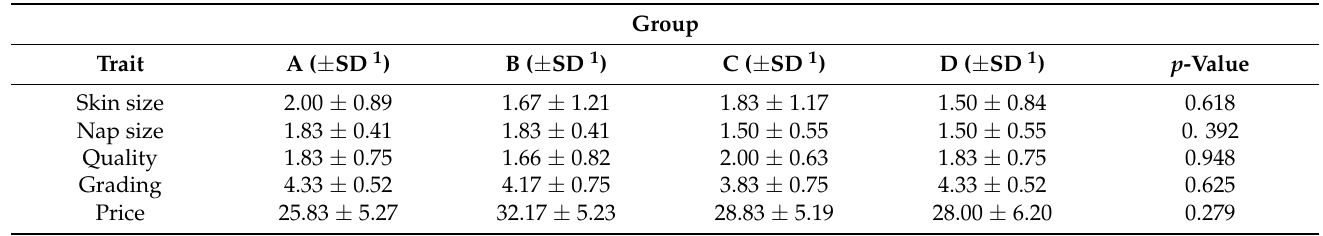
Table 4. Descriptive statistics (mean and standard deviation) for skins of female mink ( n = 6 per group).